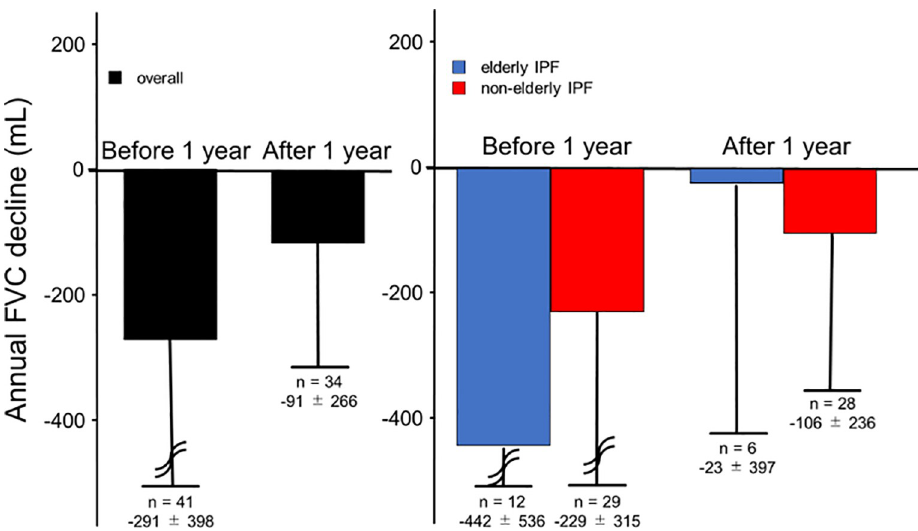
Fig 2. Annual FVC decline before and after nintedanib initiation. Changes in annual FVC decline (mean ± SD) 1 year before and after nintedanib initiation for IPF. There was a similar reduction of annual FVC decline in both the elderly and non-elderly groups. (Black: overall group, blue: elderly IPF group, red: non-elderly IPF group). Abbreviations: FVC: forced vital capacity, IPF: idiopathic pulmonary fibrosis, SD: standard deviation.